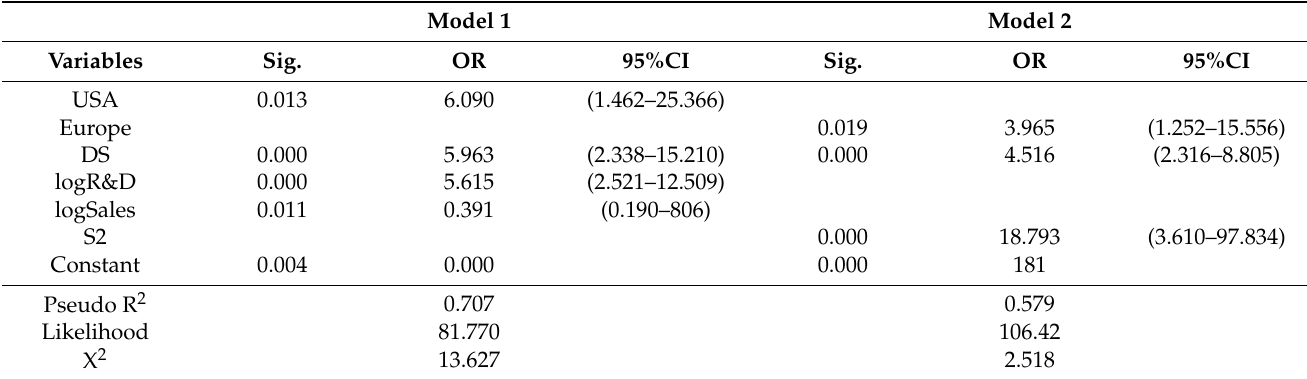
Table 3. The binomial logistic regression results for the PatientView pharmaceutical reputation ranking.